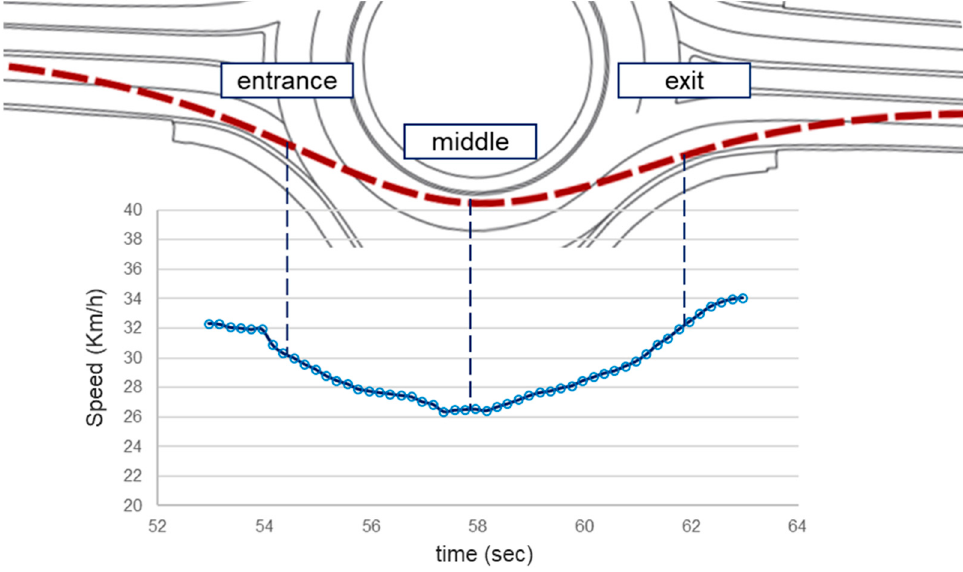
Figure 8. A typical vehicle speed profile has been extracted by processing UAV shots. The vehicle speed profile indicates significant changes in speeds because of the